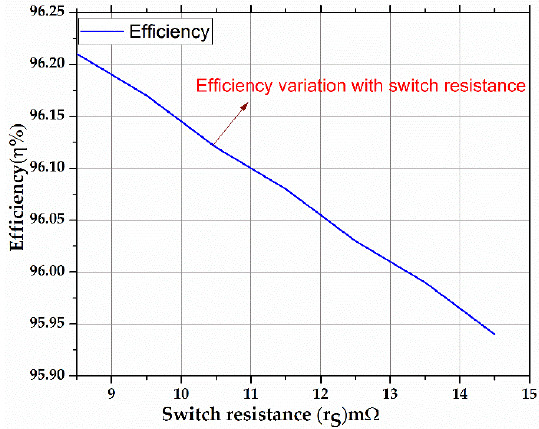
Figure 11. Variation in the theoretical efficiency with changes in r S.